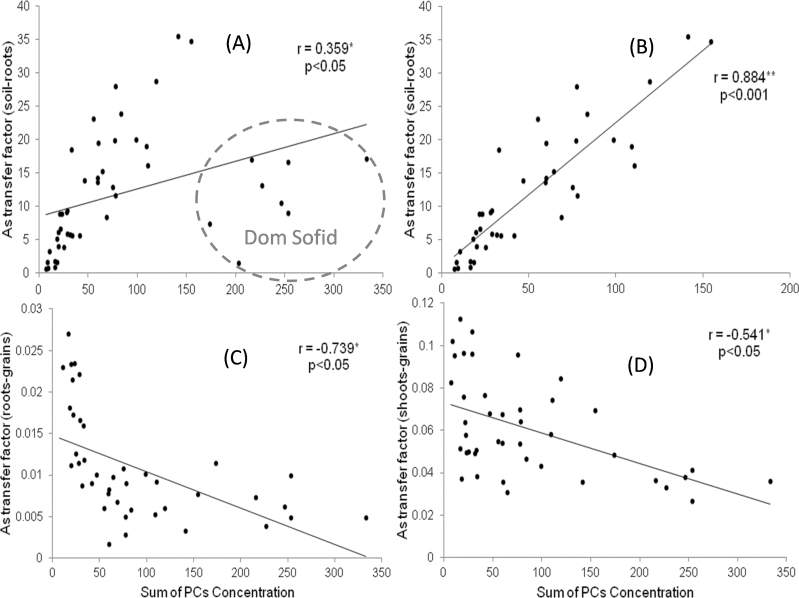
Scatter plots of PCs (sum of PCs concentration, SoP, free PCs+PCs As) on As transfer factor (TF) in all the cultivars studied: A (n=48), TFsoil–root versus SoP; B (n=40), TFsoil–root versus SoP with Dom Sofid removed; C (n=42), TFroots–grain versus SoP (all cultivars); and D (n=42), TFshoot–grain versus SoP (all cultivars).